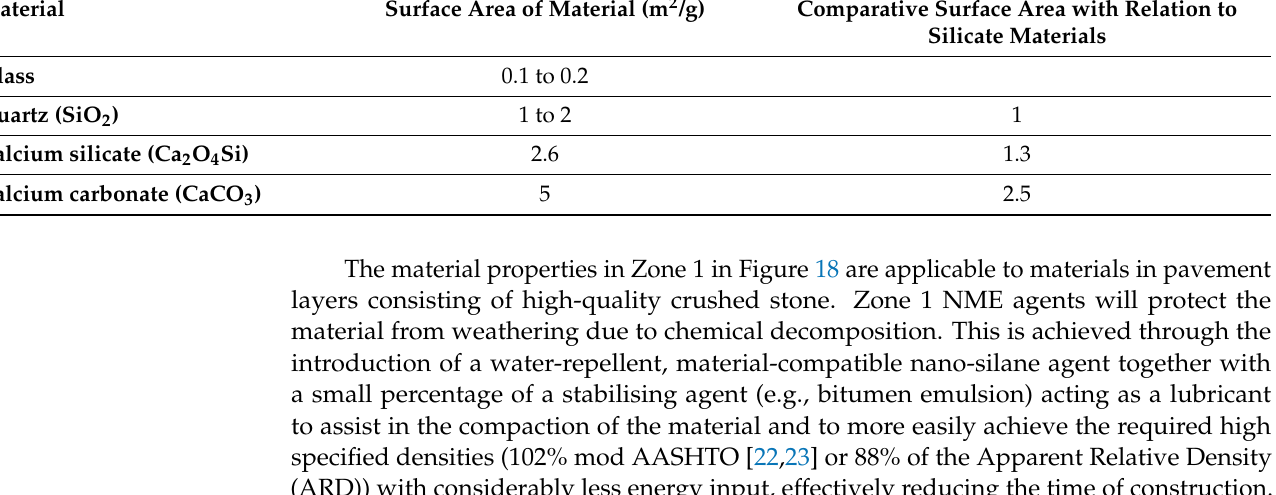
Figure 18. Demonstration of material input information required for the selection of a material compatible NME stabilising agent. Table 6. Average relative surface area (multiplication factor) of different materials per unit mass (m 2 /g) (calculated from [42]).